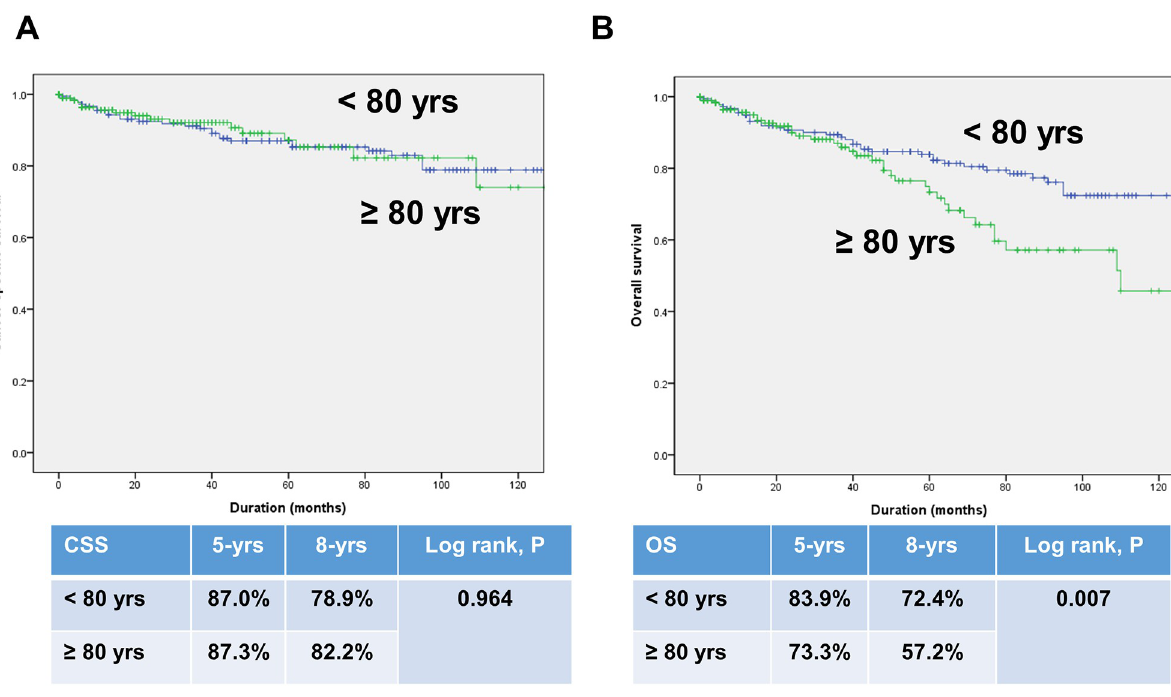
PLOS ONE | https://doi.org/10.1371/journal.pone.0283483 March 30, 2023 6 /